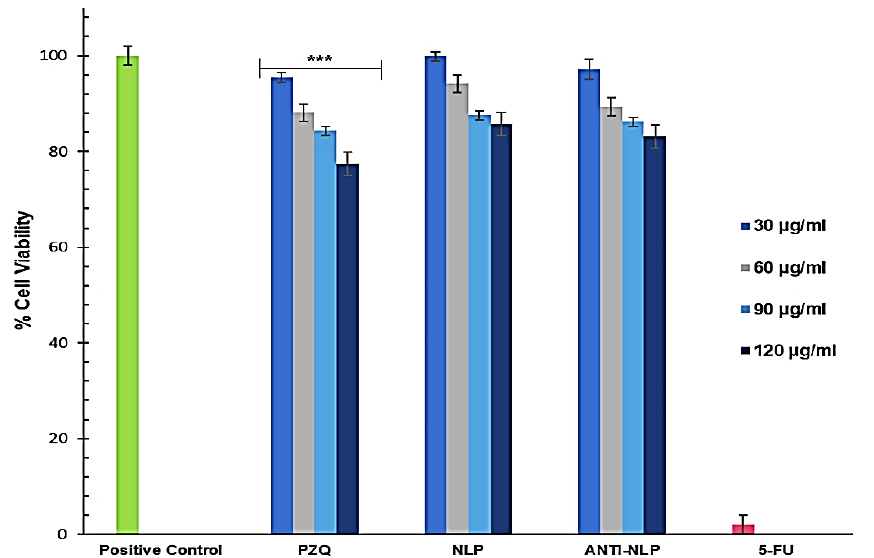
Figure 7. MTT assay measurement of the viability of 3T3 human fibroblast cells after 24 h treatment with free PZQ, NLP, and anti-calpain-NLP at different concentrations (data represent n = 3, mean ± SD). Positive control is the untreated group used to compute the percentage of cell viability. *** indicates p < 0.0001 when compared to the NLP and anti-calpain-NLP groups with the same concentration of